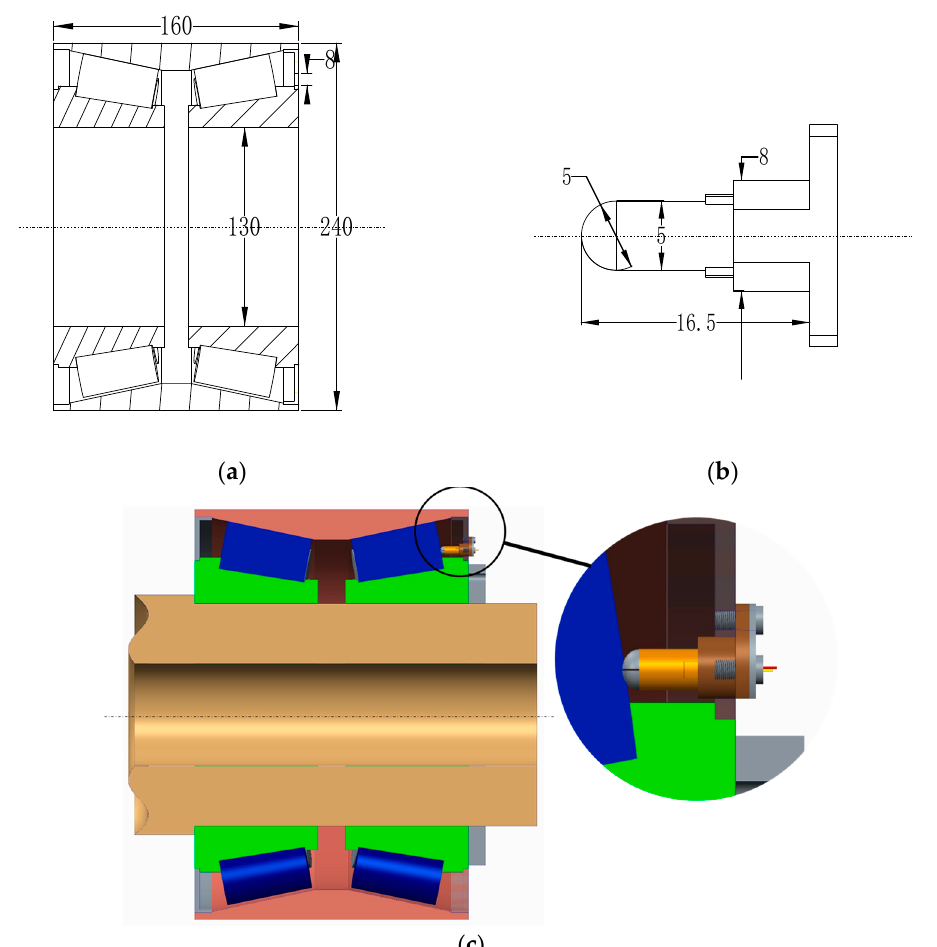
Figure 2. Bearing-sensor structure and assembly diagram: ( a ) TAROL unit structure; ( b ) temperature sensor structure; ( c ) bearing-sensor assembly diagram.